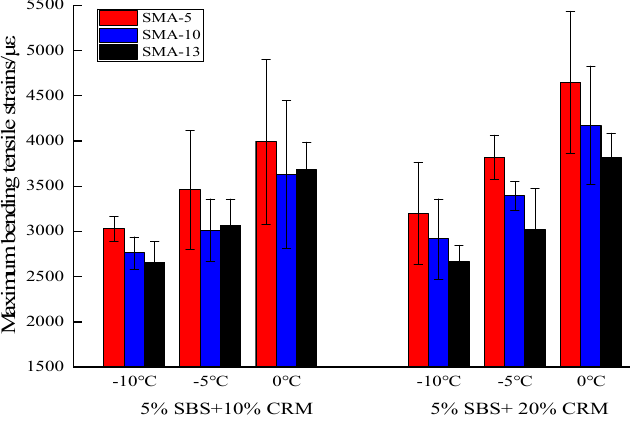
Figure 5. Bending failure tensile strains affected by NMS. Taking the case of the modified binder of 5% SBS + 20% CRM as an example, the bending fracture strains of SMA-5, SMA-10 and SMA-13 at 0 ◦ C were 4669 µε , 4177 µε and 3813 µε , respectively. The bending fracture strain decreased by 10.2% and 18.0% for SMA-10 and SMA-15, compared with the value of SMA-5. For the case of the modified binder of 5% SBS + 10% CRM, when the CRM content was reduced, the bending fracture strain of SMA-5 is 11.3% and 21.9% higher than those of SMA-13 and SMA-10. The trend was in general true for the other test temperatures and doses of